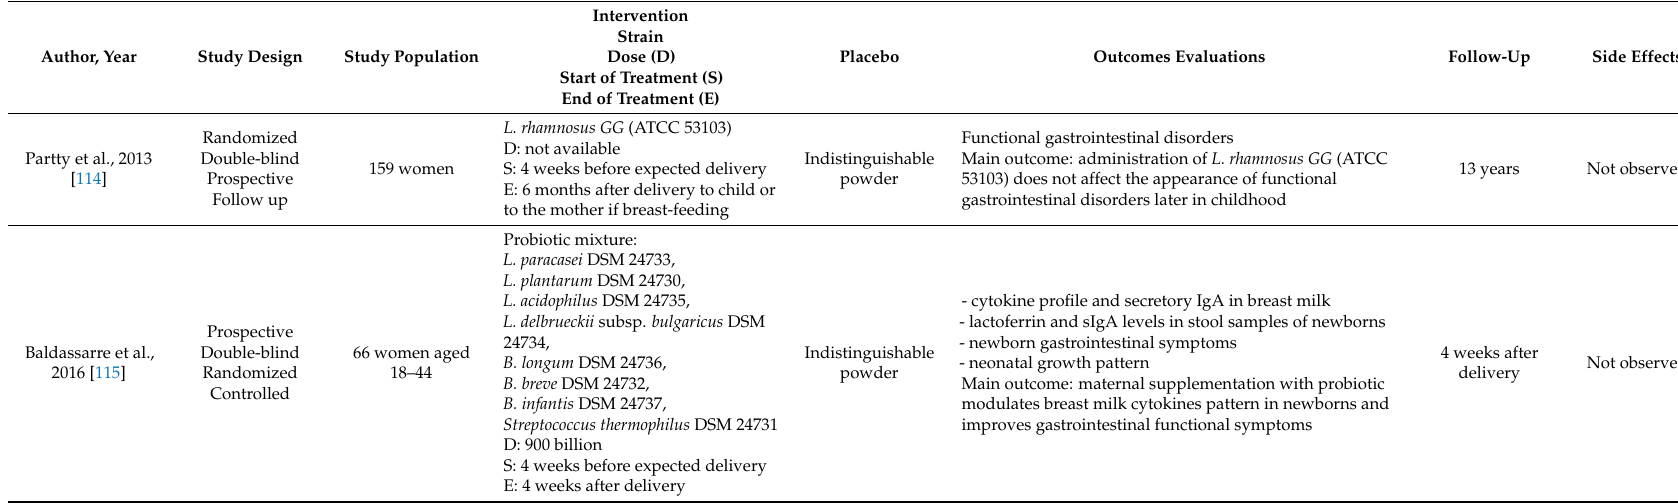
Table 3. Probiotics and functional gastrointestinal